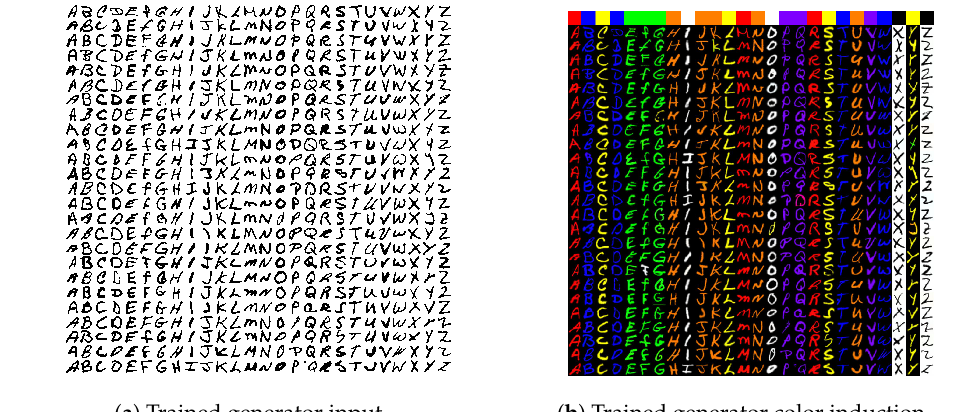
Figure 2. Synesthetic letter colorization by the trained generative network: ( a ) generator input; and ( b ) generator output. Late training: 3rd epoch, ∼ 375,000 iterations. One letter per column. Iteration count progresses from top to